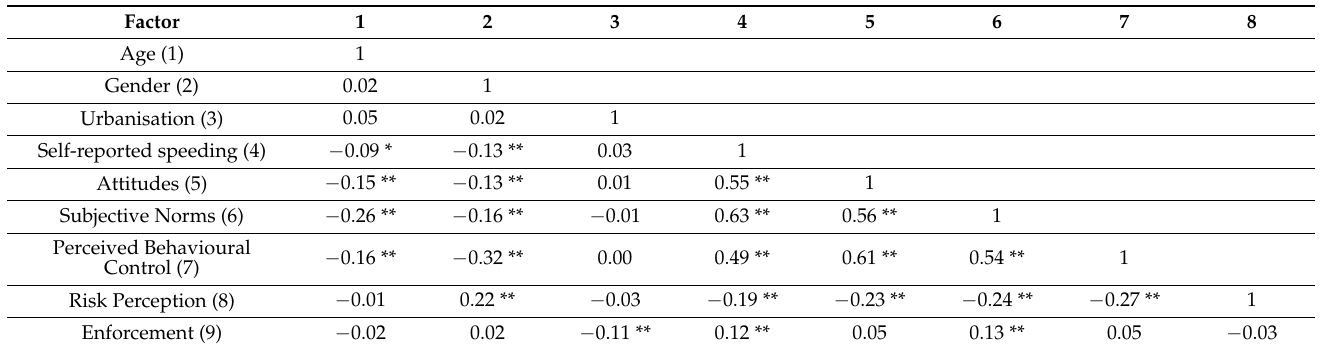
Table 4. Bivariate (Pearson/point biserial) correlations.